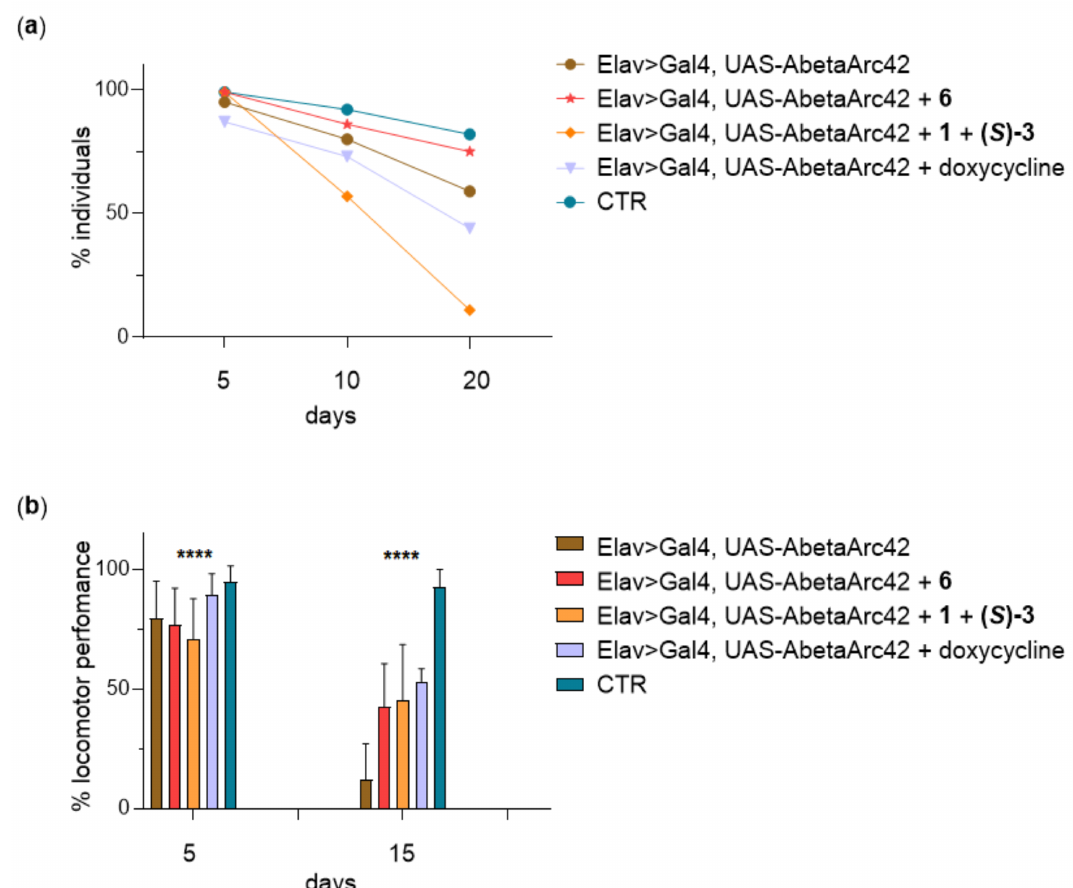
Figure 7. Behavioral studies of A β 42 -expressing Drosophila after compound 6 treatment. ( a ) Lifespan assay: the lifespan analysis compares the results at three different timepoints: 5, 10, and 20 days, ( b ) Climbing assay: the graph compares the climbing assay results at 5 and 15 days. In brown, untreated-A β 42 -expressing flies used as positive control, in red A β 42 -expressing flies treated with 6 (20 µ M), in orange A β 42 -expressing flies treated with the parent drug combination ( 1+( S )-3 , 20:40 µ M); in lilac A β 42 -expressing flies treated with doxycycline (50 µ M); in petrol blue w 1118 healthy flies, used as negative control. Two-way ANOVA test, **** p value <